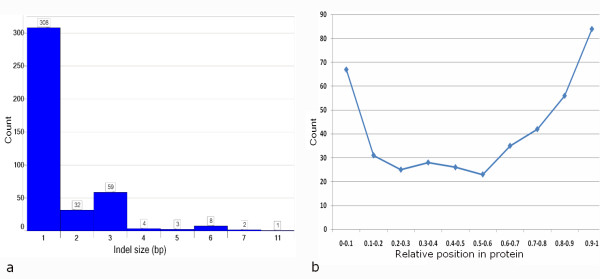
Indels in coding regions of the genome. (a) Indel size distribution in the coding regions. The indels called by all methods demonstrate strongest purifying selection against frameshifts (non 3 n) indels in coding regions. (b) Relative protein location of coding indels. The relative position of the indel in the protein was calculated by dividing the position of the indel by the total protein length.